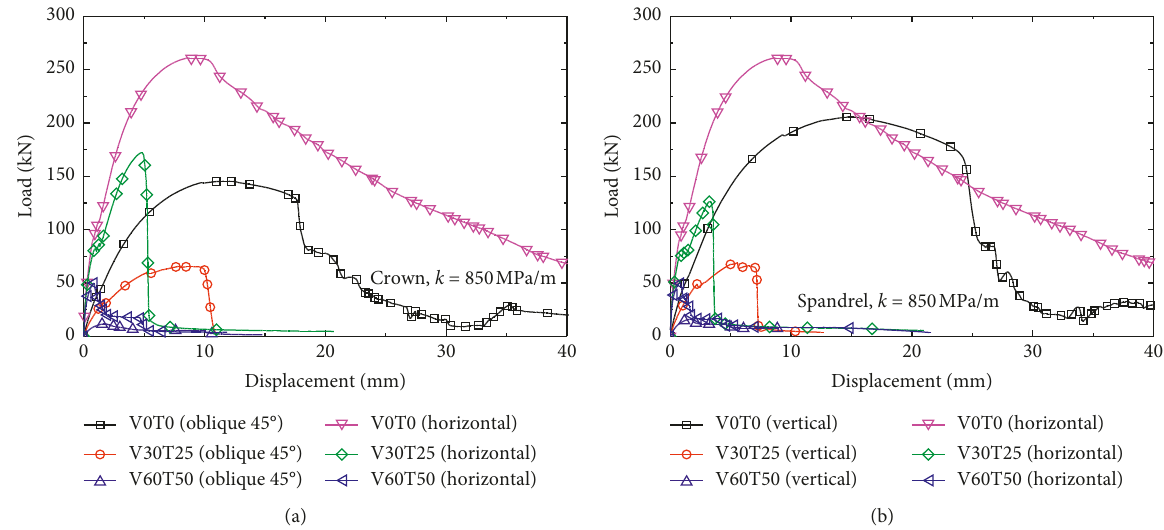
Figure 15: Load-displacement curve of lining under combined defects. (a) Defects at vault crown. (b) Defects at vault